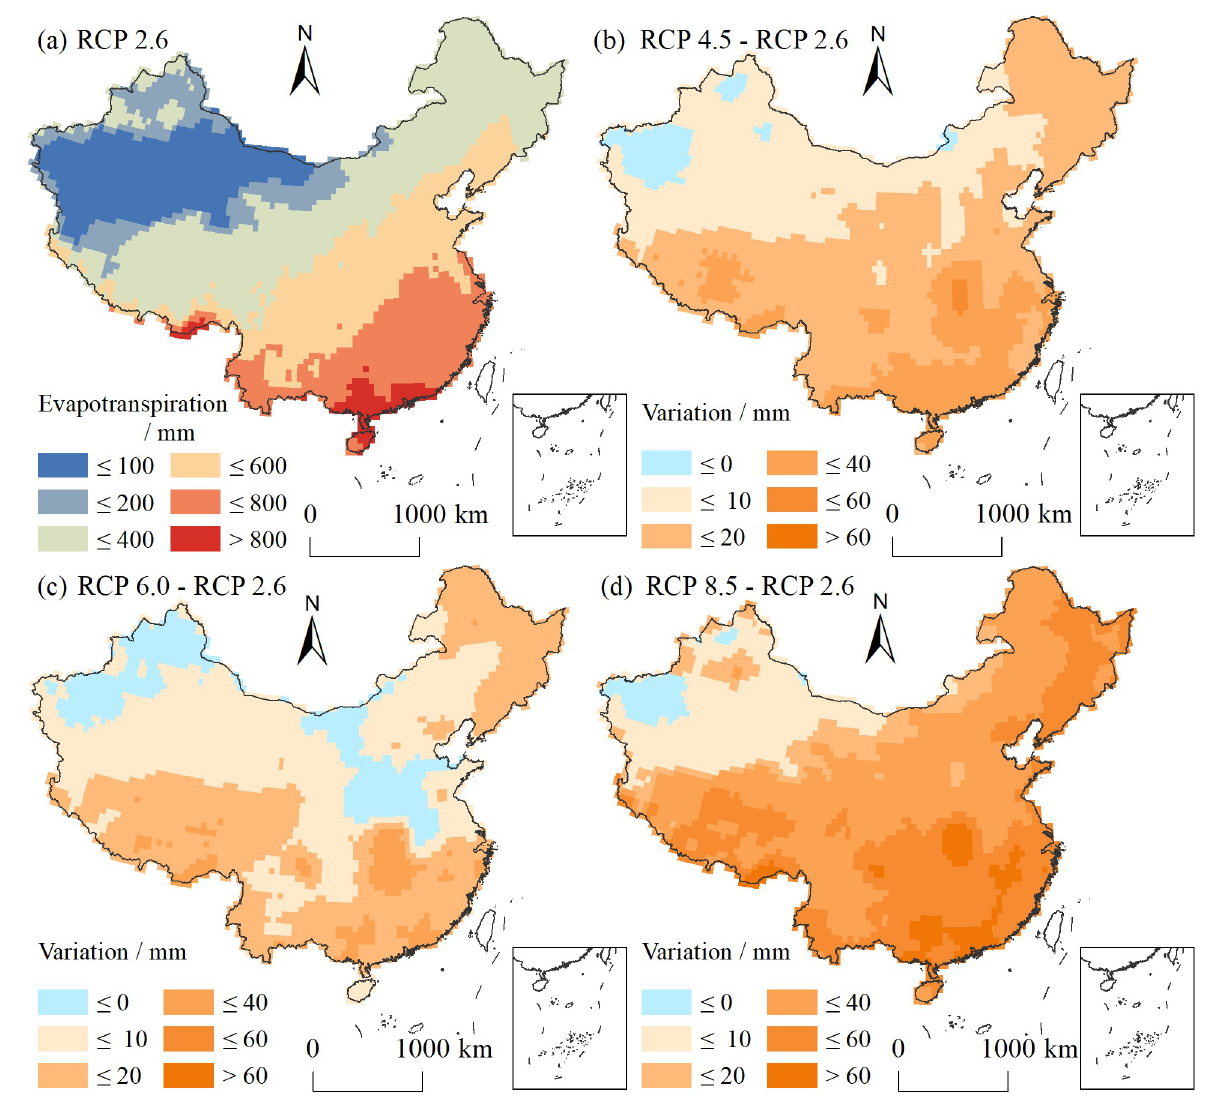
Fig 6. Changes in evapotranspiration under RCP